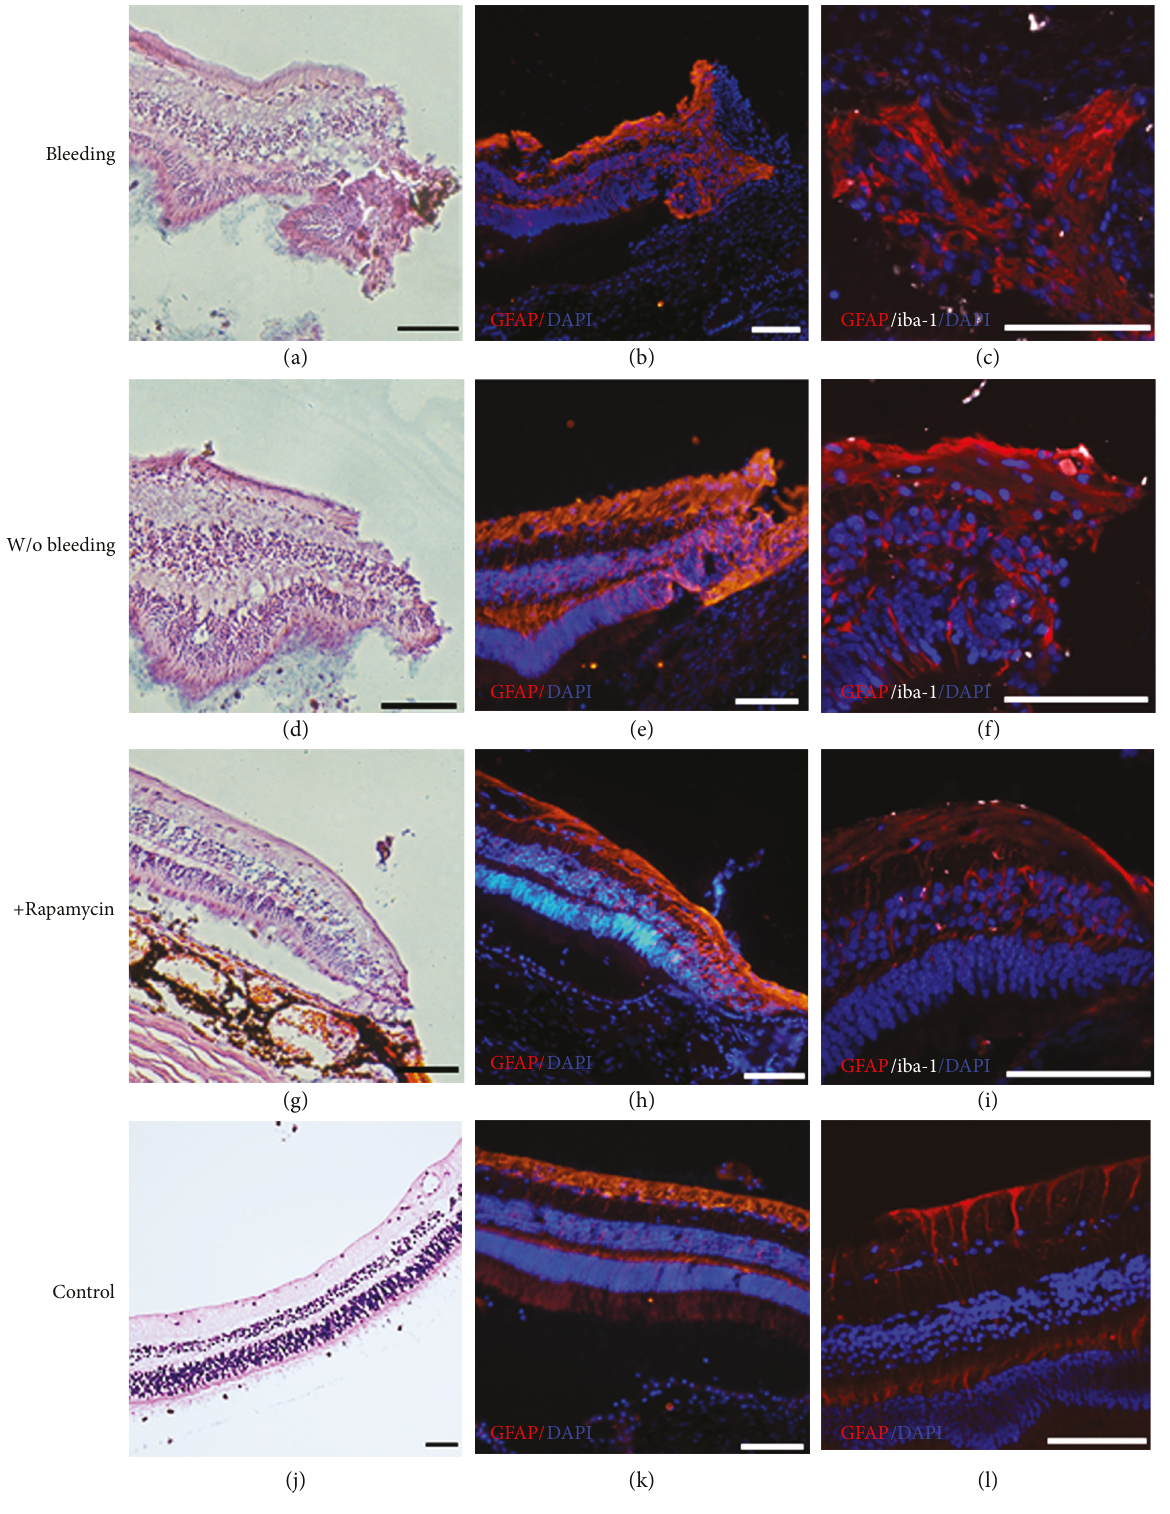
Figure 4: Glial fi brillary acidic protein (GFAP) accumulations around the retinal tack insertion area. Each line demonstrated the HE staining and immuno fl uorescence at lower and higher magni fi cations. (a – c) showed retinas with bleeding when inserting the tack. The thickening of the IPL and excessive accumulation of GFAP were observed. (d – f) showed the insertion area of the retina without bleeding during surgery. Only slight GFAP accumulation was observed, and there was no obvious thickening of the inner plexiform layer (IPL). (g – i) showed much slighter retinal in fl ammation in the presence of rapamycin. (j – l) showed the appearance of a control rhesus retina. Moreover, iba-1 staining showed no activation of microglia (scale bar =100 μ